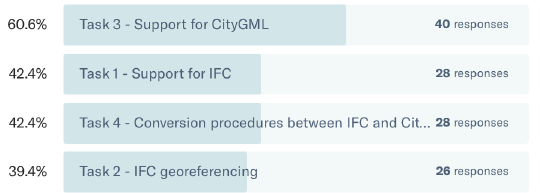
Figure 4. Registrations for performing each benchmark task.